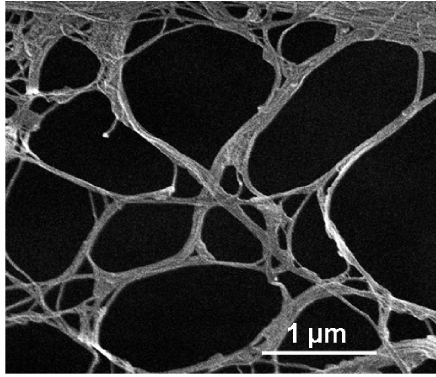
Figure 3. Scanning electron microscopy (SEM) image of nanocellulose (NC) from defibrillated membranes showing a sparse network of nanofibers.